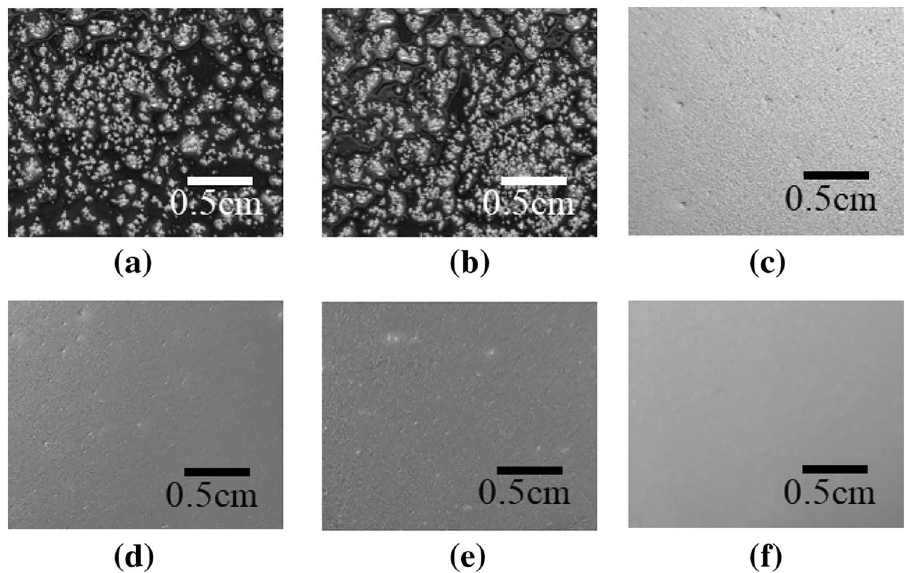
Figure 4. Surface of the spin-coated (2000 rpm) present porous PDMS layer, fabricated at WMR = 0.5 for varying t